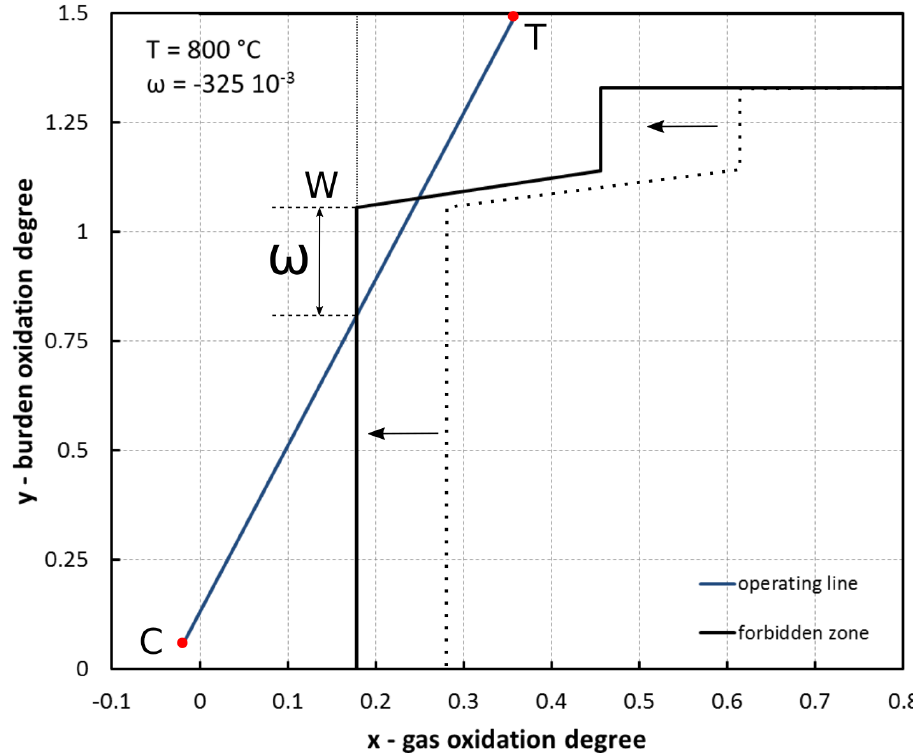
Figure 5. Operating diagram for Midrex NG TM module 2 in ArcelorMittal Contrecoeur plant on April 2016, assuming 100% in situ reforming in the prereduction zone.